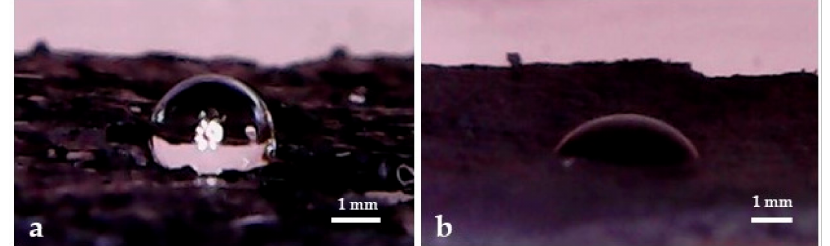
Figure 7. Images of the droplets water over MWCNTs ( a ) and carbon nanofibers (CNFs) ( b